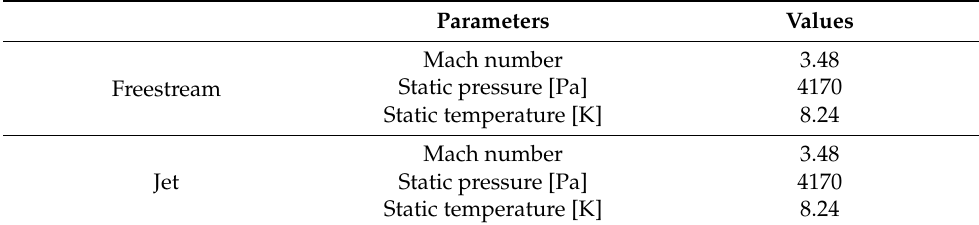
Table 6. Boundary condition of reference